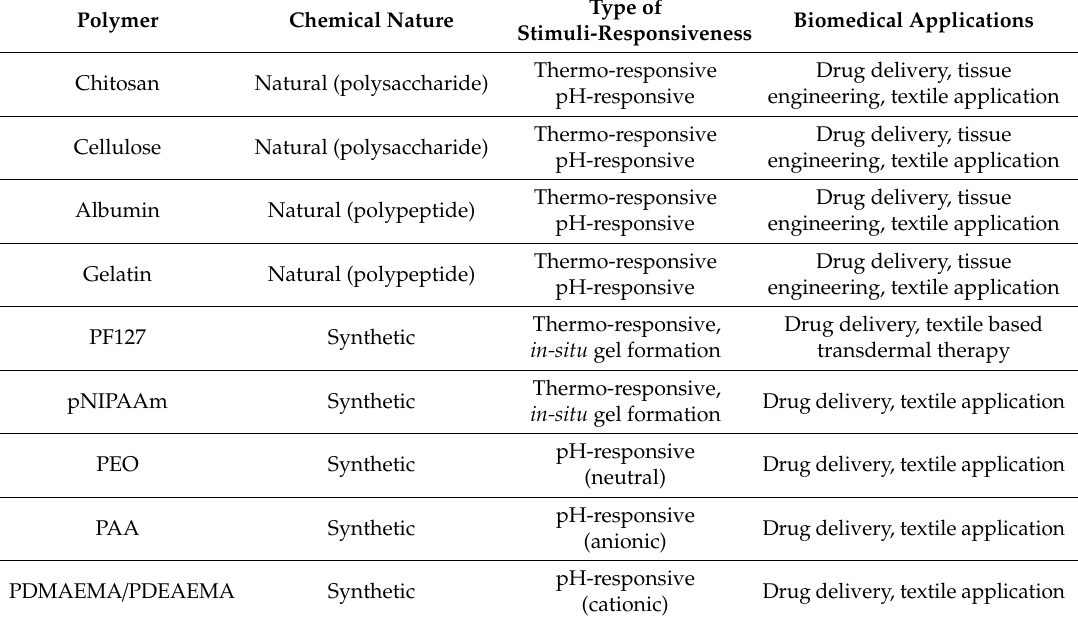
Chemical nature, type of stimuli-responsiveness, and biomedical applications of stimuli-responsive